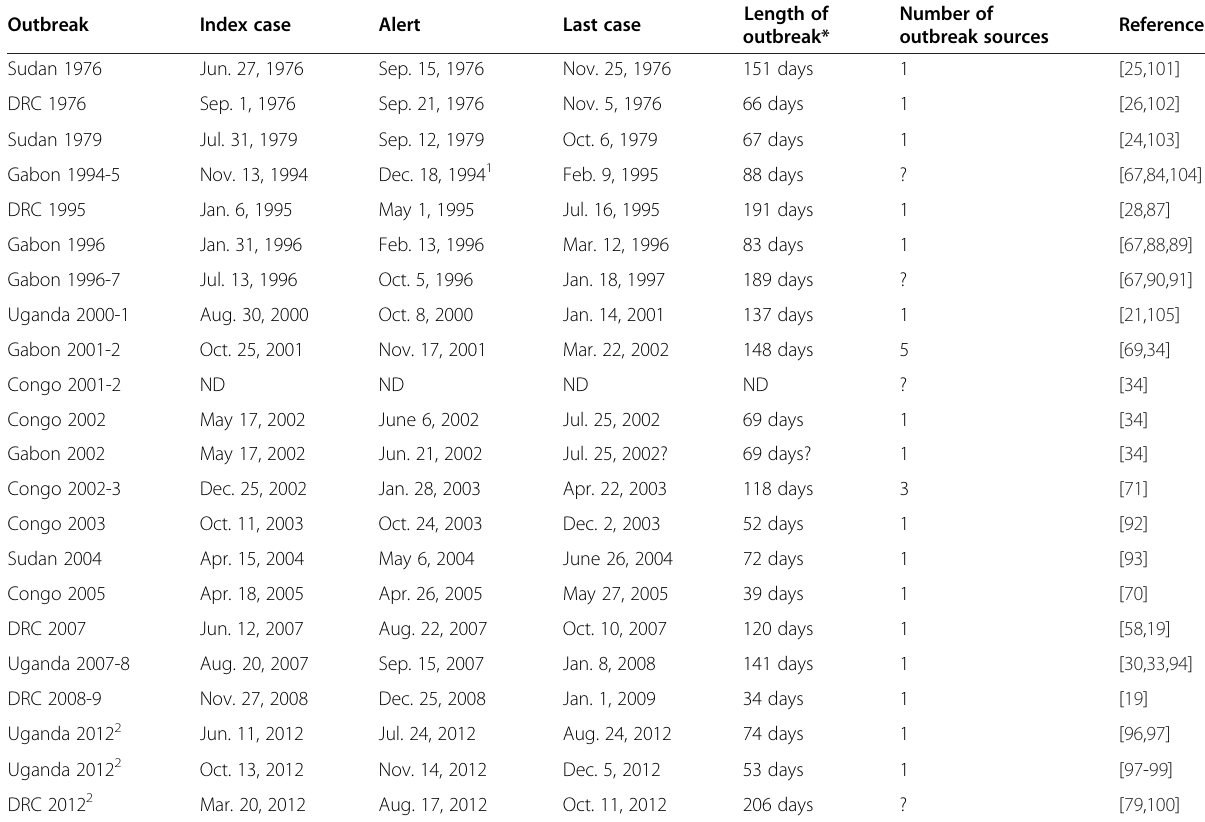
Table 5 Length of African Ebola outbreaks Outbreak Index case Alert Last case